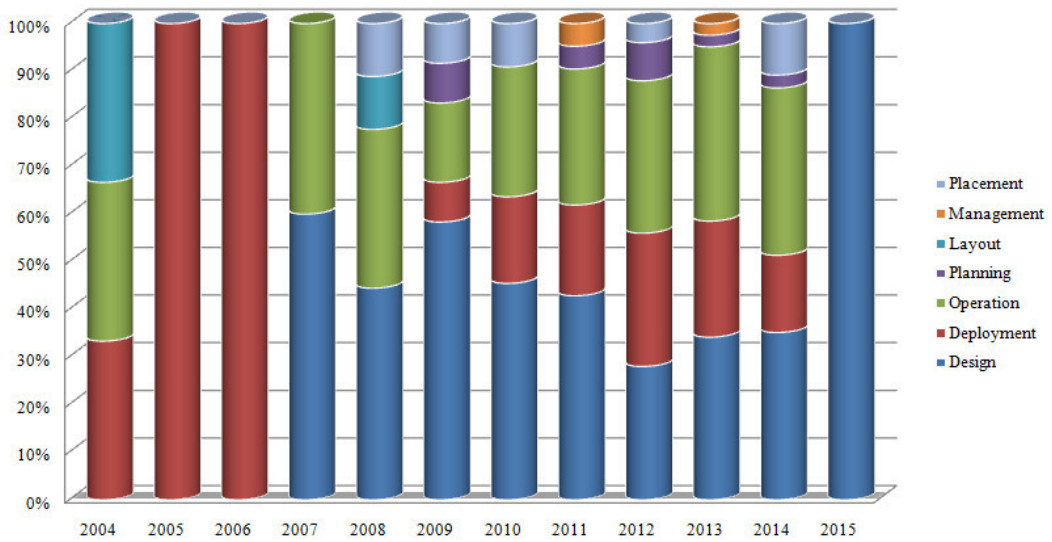
Figure 7. Trend of research community w.r.t. optimization